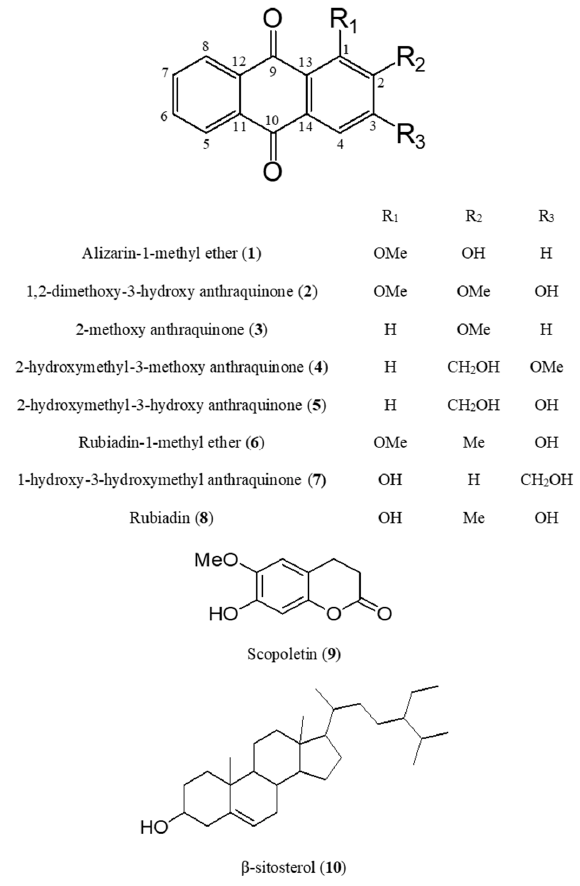
Figure 1. Structures of compounds 1 – 10 .